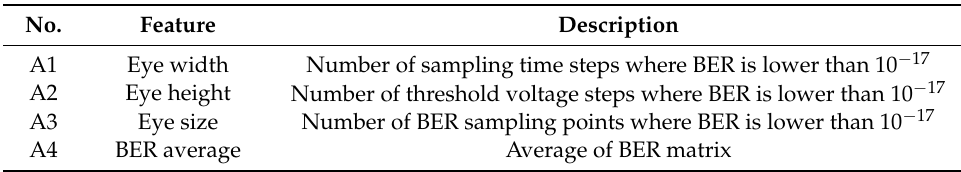
Table 1. Feature set description. BER—bit error rate.